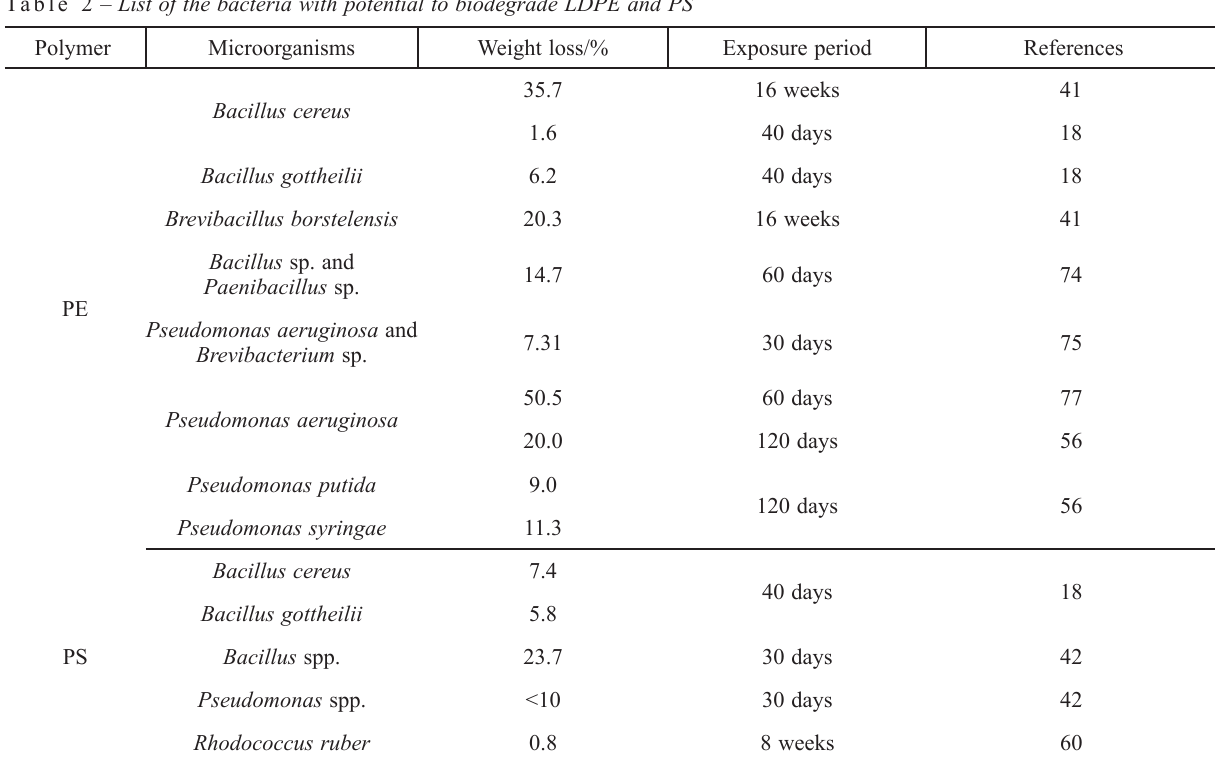
Table 2 – List of the bacteria with potential to biodegrade LDPE and PS Polymer